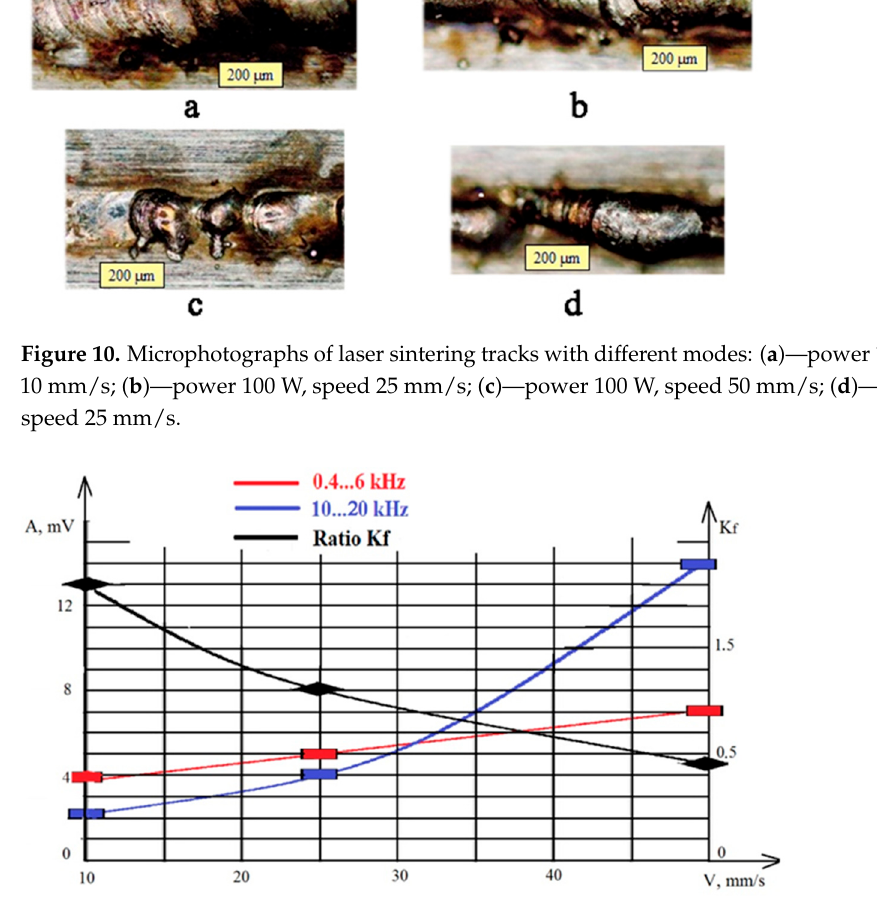
Figure 10. Microphotographs of laser sintering tracks with different modes: ( a )—power 100 W, speed 10 mm/s; ( b )—power 100 W, speed 25 mm/s; ( c )—power 100 W, speed 50 mm/s; ( d )—power 50 W, speed 25 mm/s.